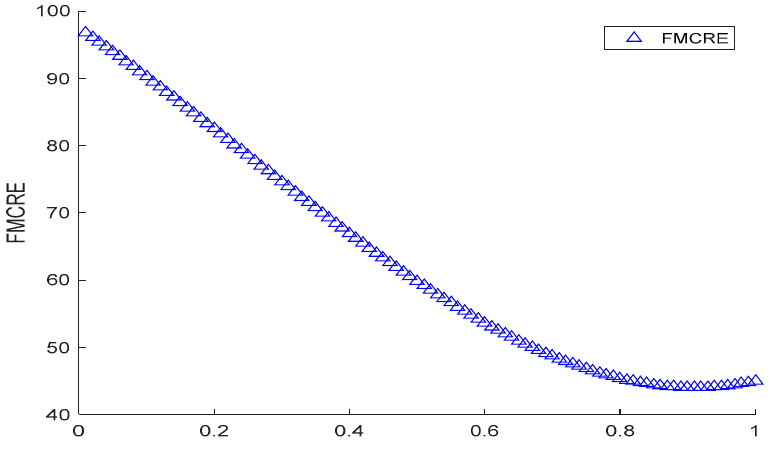
Figure 1. The fractional cumulative residual MRE of exponential distribution with λ 1 = 0.5 and λ 2 = 0.8. The next proposition explains the effect of linear transformation on FCMRE. That is, the linear invariance of FCMRE.